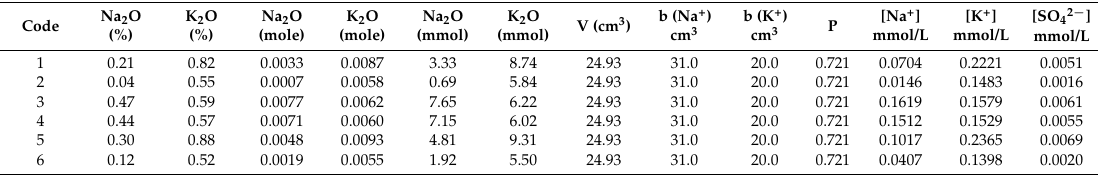
Table 10. Na 2 O or K 2 O concentrations (mmol/L) in the pore solution at 28